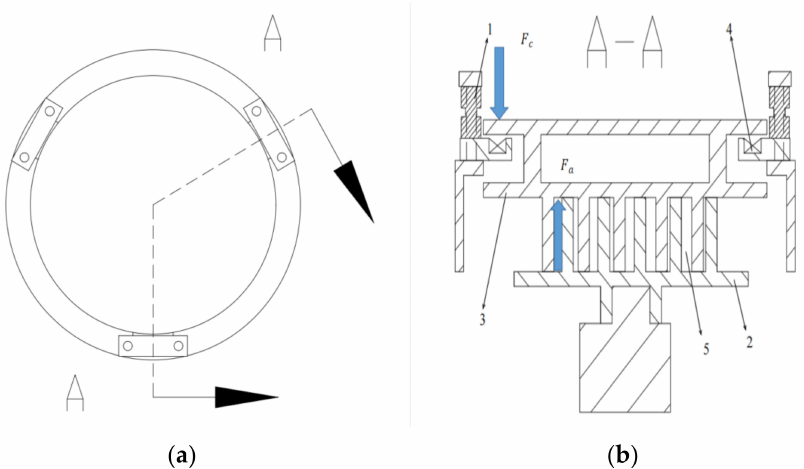
Figure 1. Schematic diagram of electromagnetic balance scheme for axial gas force of the scroll compressor: ( a ) the top view of the structure; ( b ) the sectional view from A-A direction; 1—pressure sensor; 2—moving vortex disk; 3—static vortex disk; 4—electromagnet; 5—compression